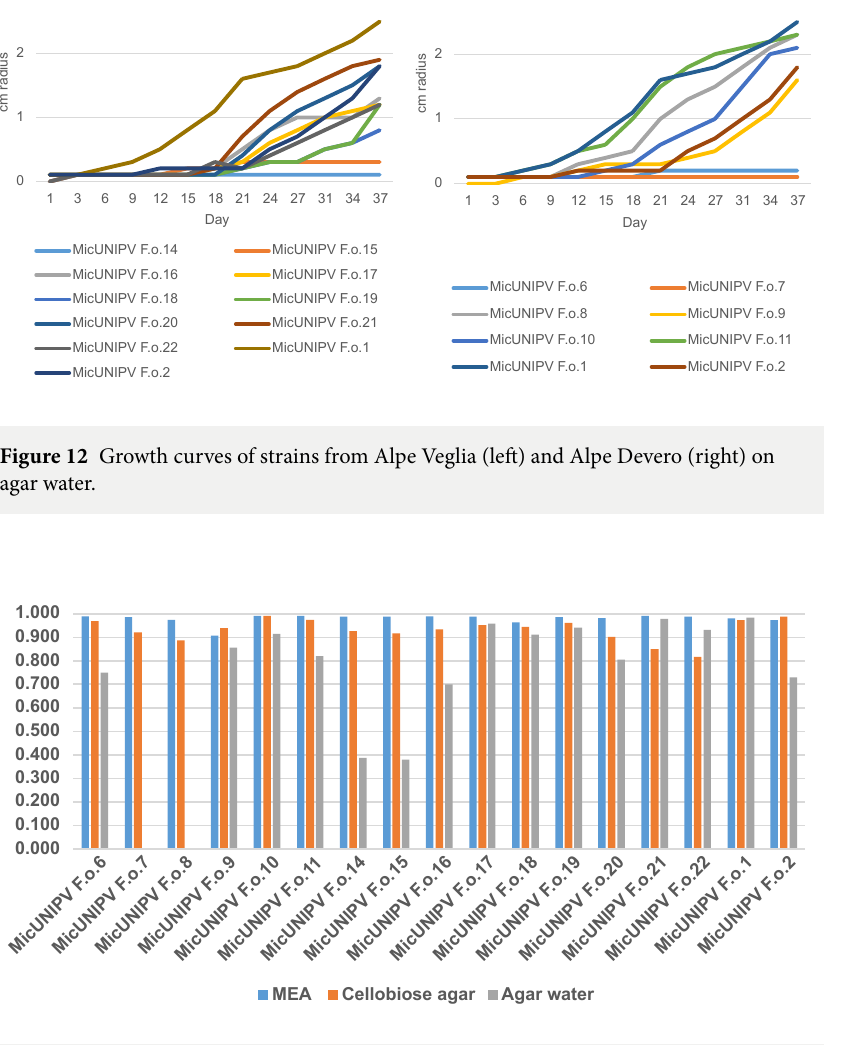
Figure 13 R 2 coefficients for the linear regression of growth curves.